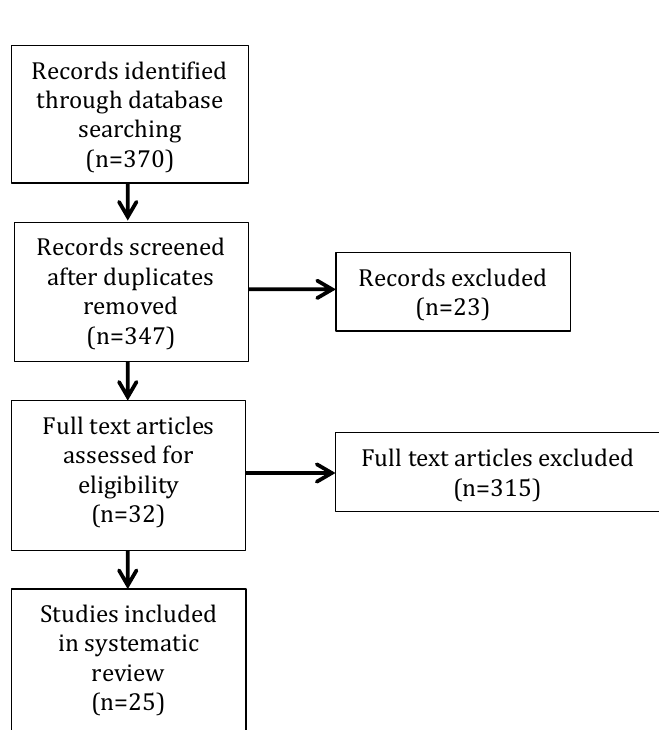
Fig. 1. Flow diagram of search results for smoking cessation program using the PRISMA